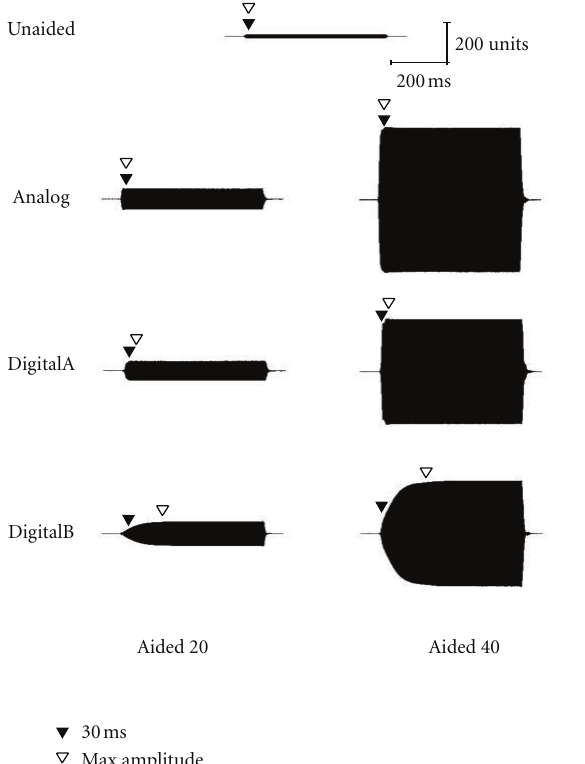
Figure 5: Waveform of the long stimulus presented at 50 dB SPL as measured in the ear canal of a single representative subject (subject 2).